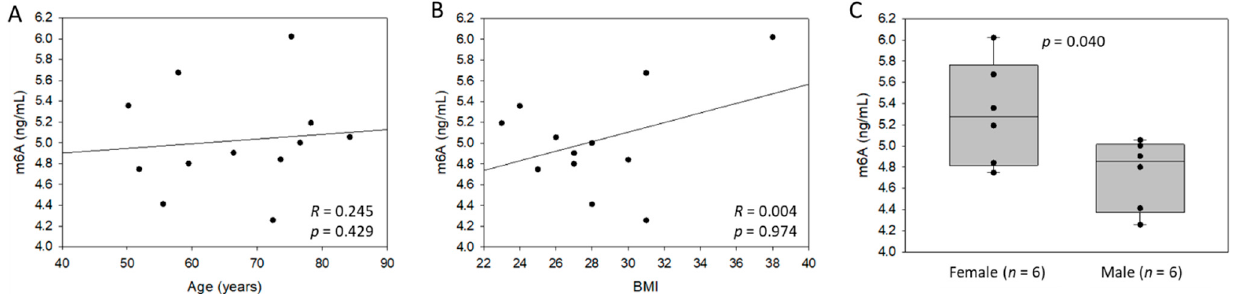
Figure 3. M6A levels in the blood of 12 patients after myocardial infarction (MI): association with age ( A ), body mass index (BMI) ( B ) and gender ( C ). M6A content was assessed by LC-MS using total RNA extracted from whole blood samples. Spearman correlation coefficients and p -value are indicated.